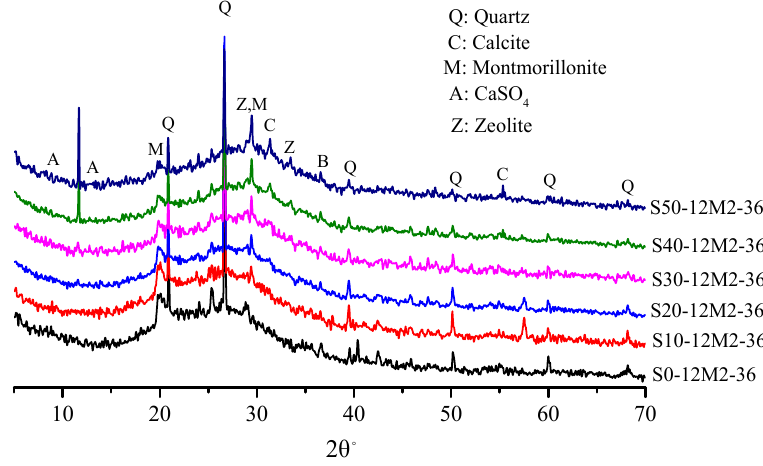
Figure 5. The XRD patterns of AACGS samples with di ff erent slag